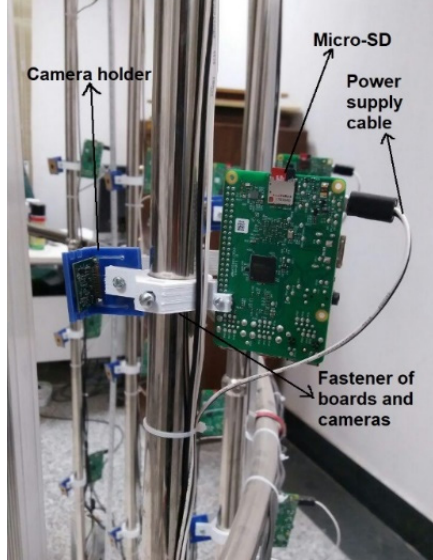
Figure 2. Fastener and holder of controllers and cameras.